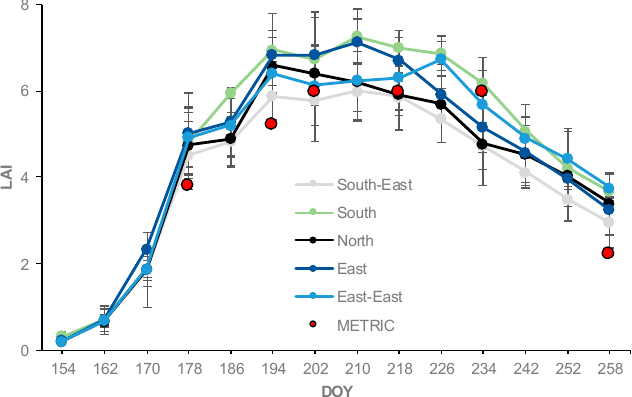
Figure 5. Seasonal progression and comparison of LAI estimated with the METRIC model (average of the five locations in each date, red circles) and measured with AccuPAR (five locations, each location with five points and five replications per location) throughout the season. Vertical bars represent 2 standard deviations of LAI values measured in situ with AccuPAR.